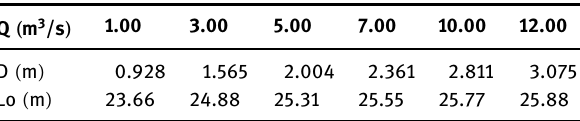
Table 3: Value of optimum diameter and optimum span length